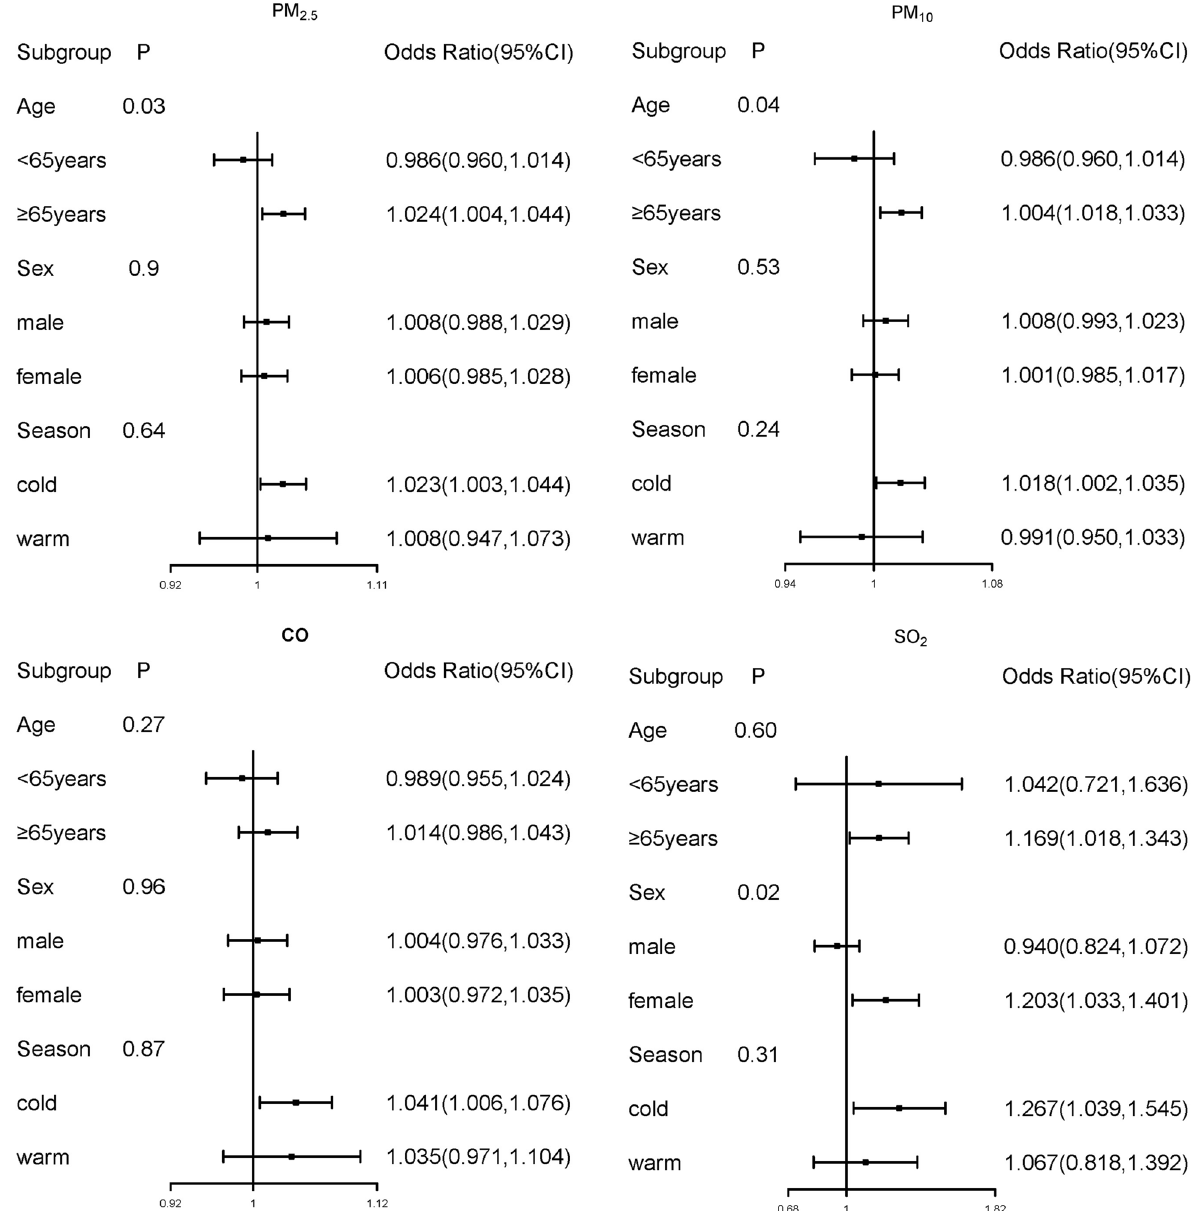
a conservative point of view. The results are shown in Table 3. Based on the WHO air quality guidelines, 430 patients were admitted to the hospital with AF from 2017 to 2018 due to excessive exposure to PM 2.5 . For PM 10 exposure, the counterpart number of patients